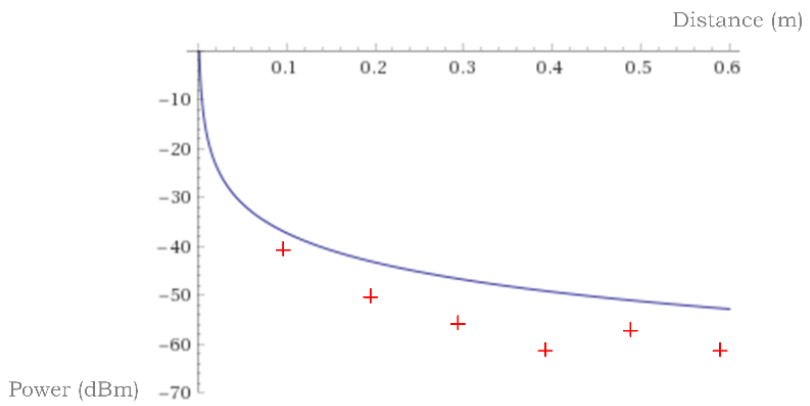
Figure 14. Theoretical model for power received at a certain distance (blue line) versus real values captured at specific distances (red points).